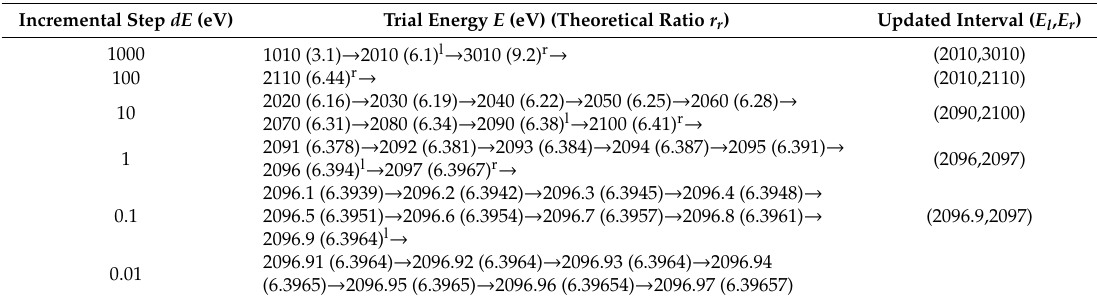
E E of trial l r